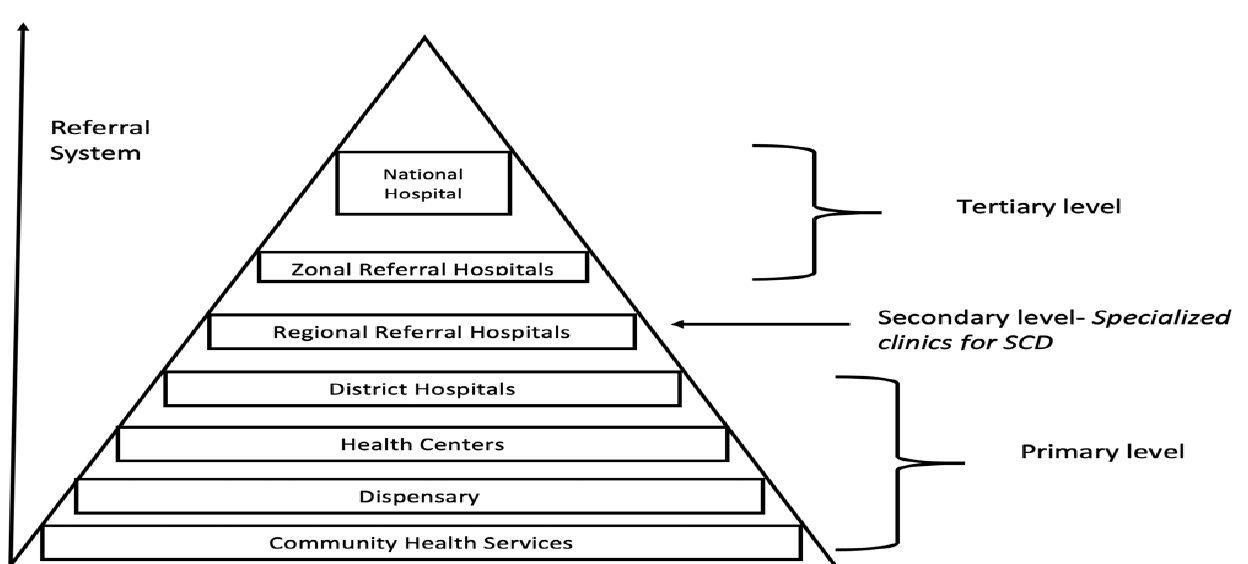
Figure 4. Illustration of the referral structure of the health care delivery services in Tanzania, with specialized clinics for SCD currently concentrated at the regional referral